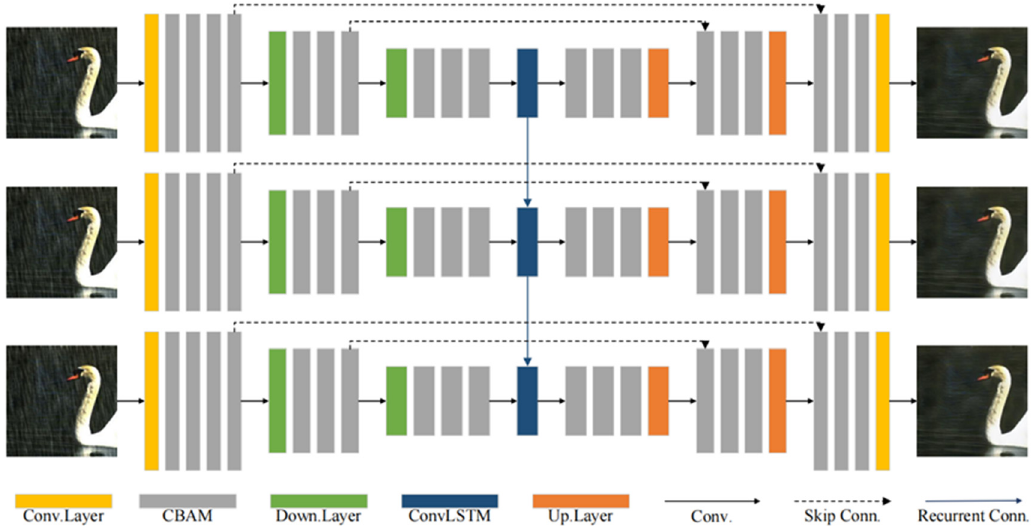
Figure 2. The overall structure of our proposed generator. The CBAM part is shown in Figure 1. Our generator is a variant of the recurrent neural network, which offers three cycles in the figure above. The parameters of the three cycles are shared, that is, only one-third of the parameters of the overall network. The generator does not need to be pretrained. In the adversarial training, the pretrained discriminator is used to conduct adversarial training with the generator proposed above.